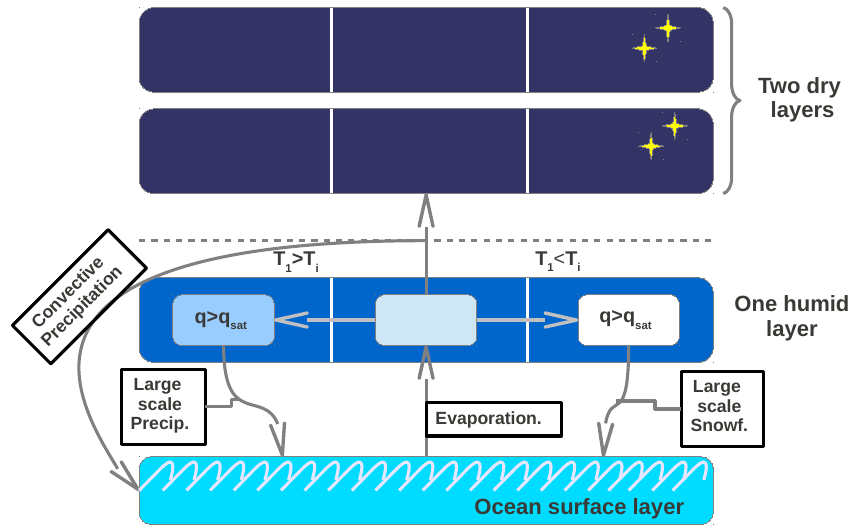
Fig. 1. Schematic representation of the water cycle in ECBilt. The abbreviation are as follow: q sat stands for saturation humidity and q for humidity; T i stands for limit temperature for snowfall and T 1 is the temperature of the first layer of the atmosphere; “Snowf.” stands for Snowfall and “Precip” for